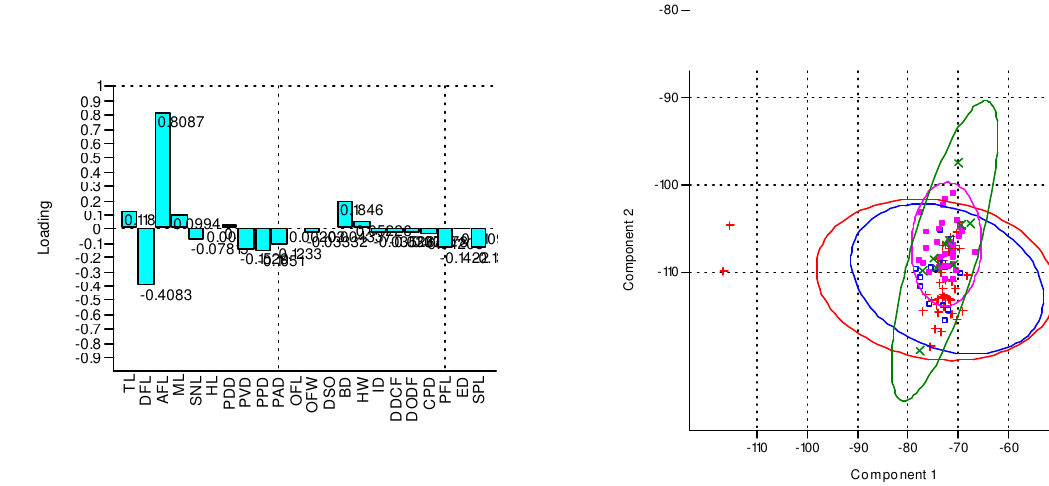
Fig. 4. PCA scatter diagram (95% ellipses) of the morphometrics of wild and cultured Clarias gariepinus of both genders * Red color indicates wild population (male), blue color indicates wild population (female), pink color indicates cultured population (male) and green color indicates cultured population